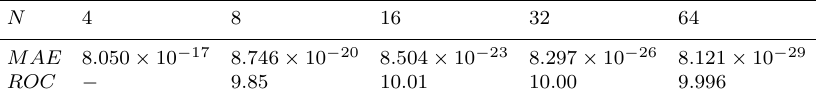
Table 4. Maximum absolute errors (MAE) and rate of convergence (ROC) obtained for Example 1. N 4